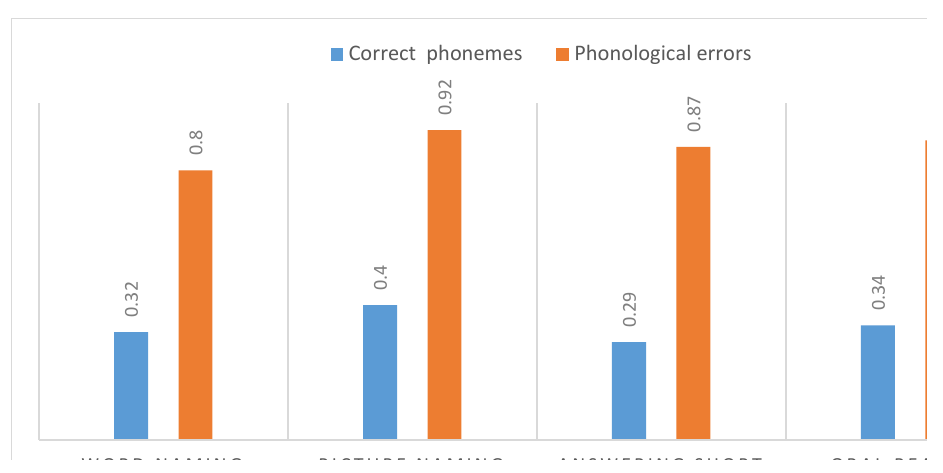
Figure 1: KW’s Correct Phonemes and Phonological Errors